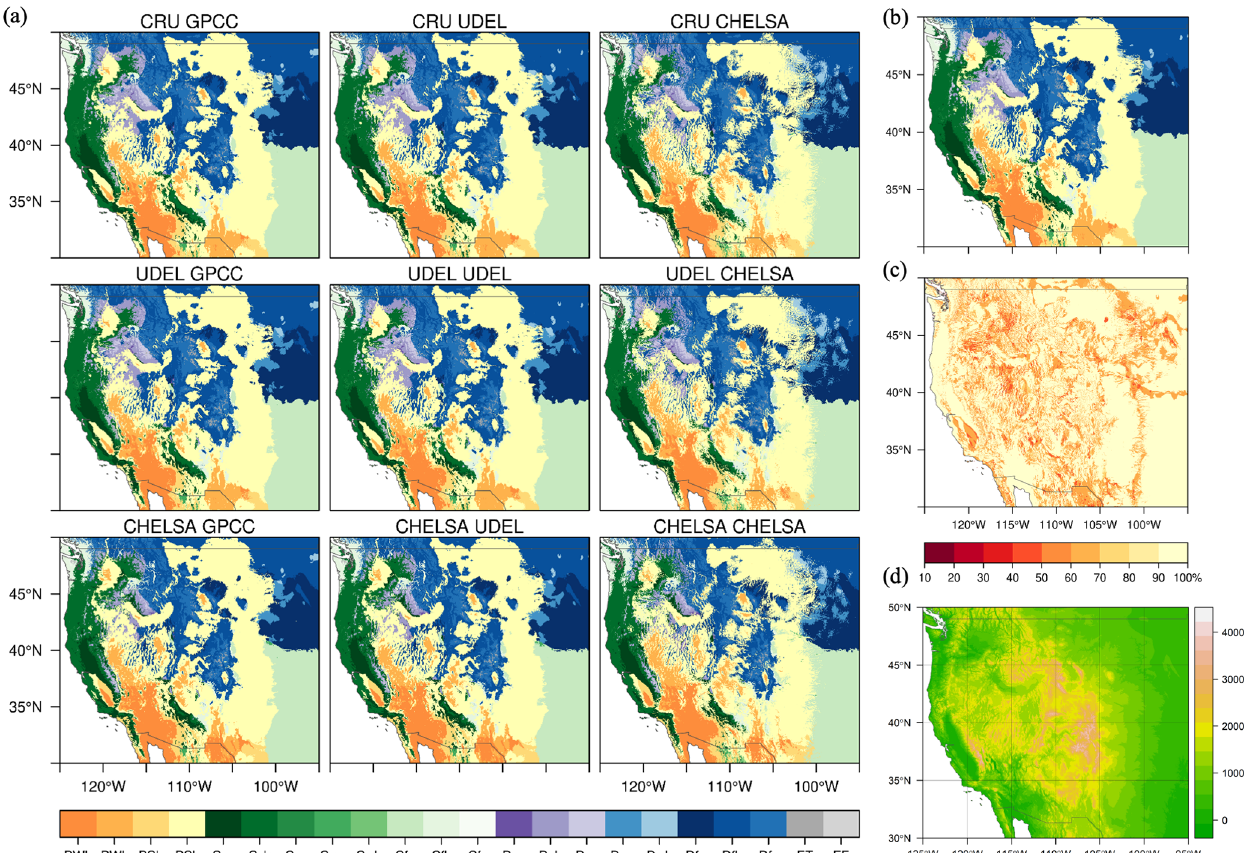
Figure 4. Present Köppen–Geiger classification and confidence map for 1979–2008 with resolution of 1km for the central Rocky Mountains in North America. (a) Climate maps based on the nine combinations of the three precipitation datasets and three surface air temperature datasets, (b) the final climate map derived from the most common climate class among the nine climate maps, (c) confidence level distribution of the final climate map, and (d) elevation map for the central Rocky Mountains in North